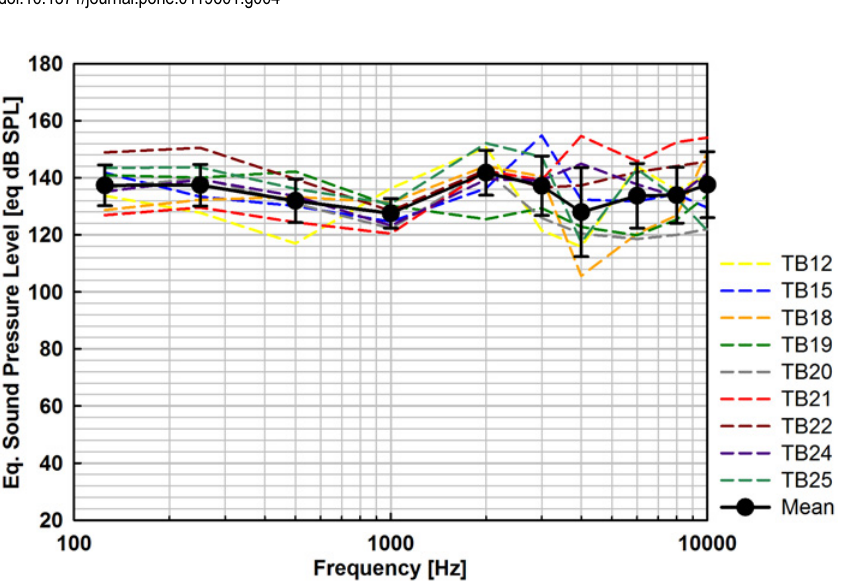
Fig 5. Eq. sound pressure output level (N = 9) of Codacs stimulation with the Bell prosthesis at the SH for nominally 1 V rms actuator input voltage.